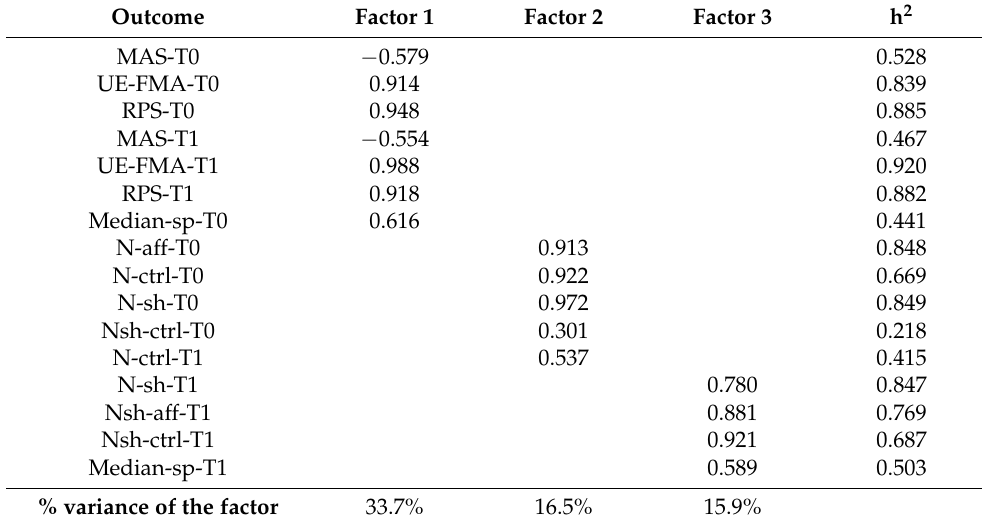
Table 3. EFA-All, with promax rotation for all